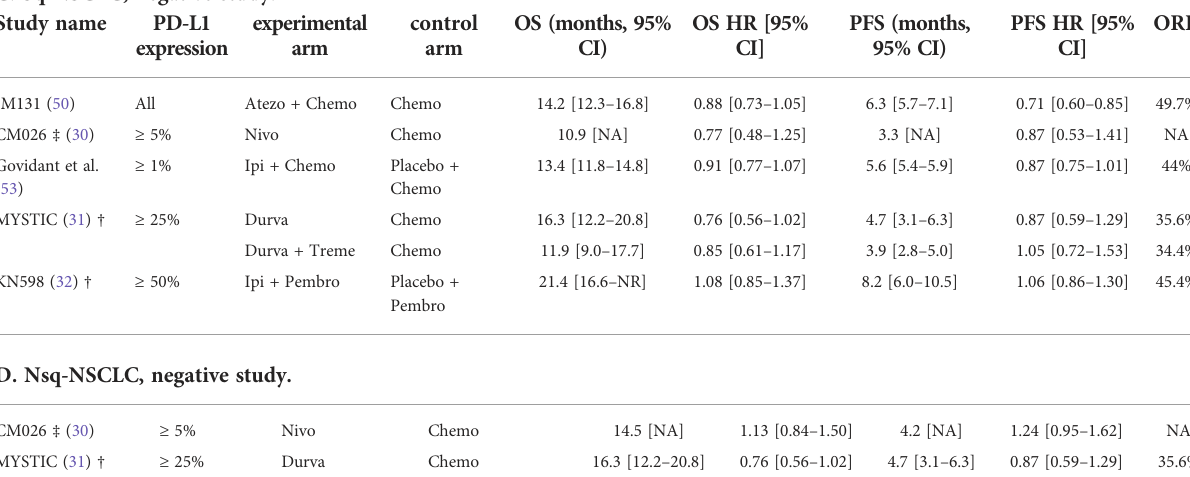
TABLE 1 Key clinical trials that tested ICI regimens for treatment-naïve patient. C. Sq-NSCLC, negative